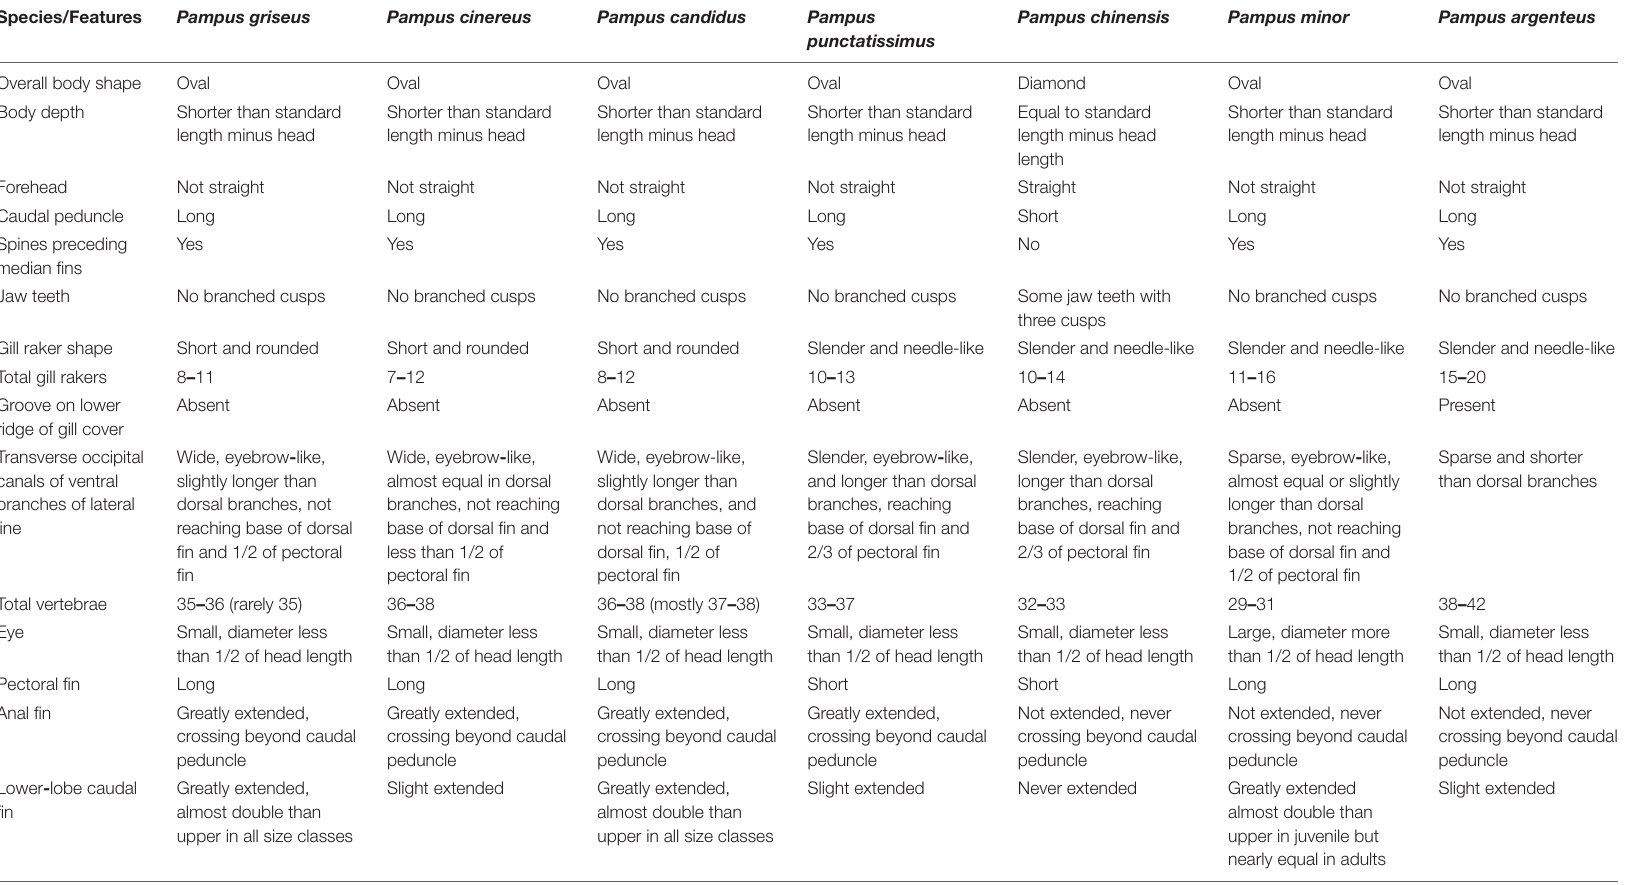
TABLE 4 | Comparison of the morphological characteristics of seven species of Pampus from the Indo - Western Pacific Oceans.